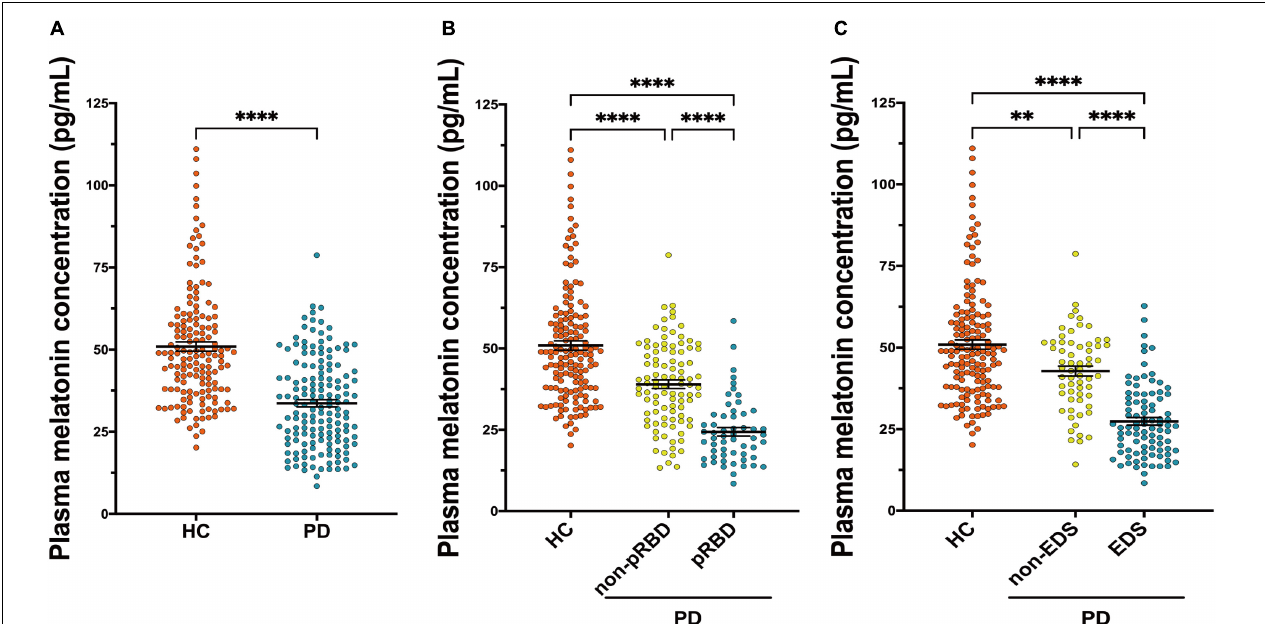
FIGURE 3 | Scatter plots of melatonin concentration in the plasma of HC ( n = 156) and PD ( n = 153). (A) Plasma melatonin concentration was significantly decreased in patients with PD than in HC ( P < 0.0001). (B) PD patients with pRBD ( n = 56) had significantly lower melatonin concentration compared with those in HC ( n = 156, P < 0.0001) and PD patients those without pRBD ( n = 97, P < 0.0001). A significant difference in melatonin concentration was found between HC and PD without pRBD ( P < 0.0001). (C) Alterations of plasma melatonin concentration were found between PD with EDS ( n = 92) and PD without EDS ( n = 64, P < 0.0001), and both of two groups have significant lower melatonin concentration when comparing to HC (PD with EDS, P < 0.0001; PD without EDS, P < 0.01). ∗∗ P < 0.01 and ∗∗∗∗ P < 0.0001.